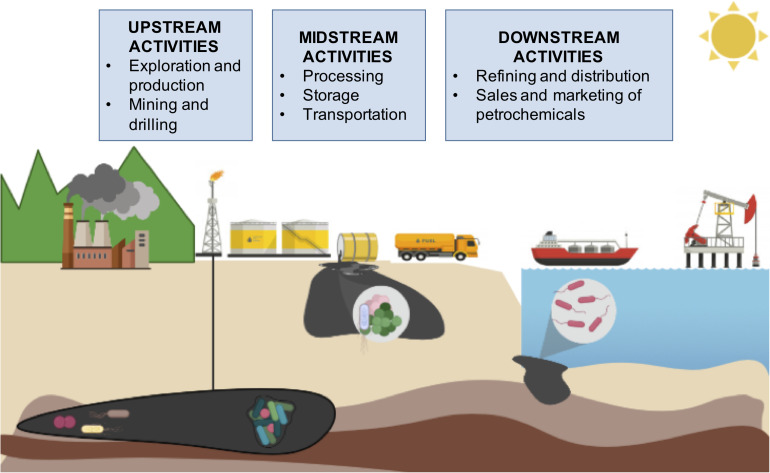
Oil supply chain.